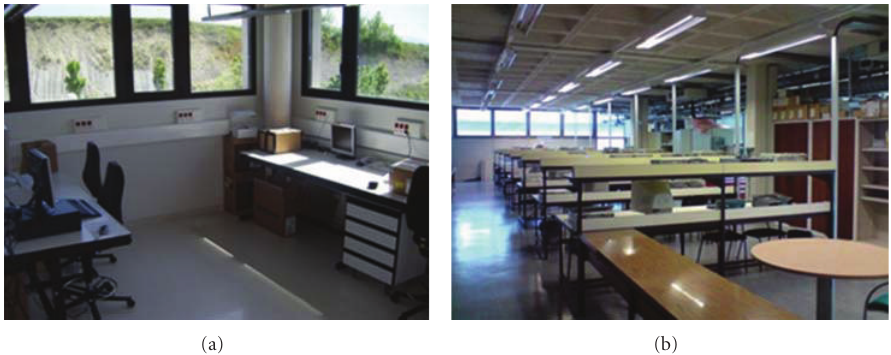
Figure 2: (a) R&D building’s laboratory no. 5 picture. (b) Radio communication laboratory picture.